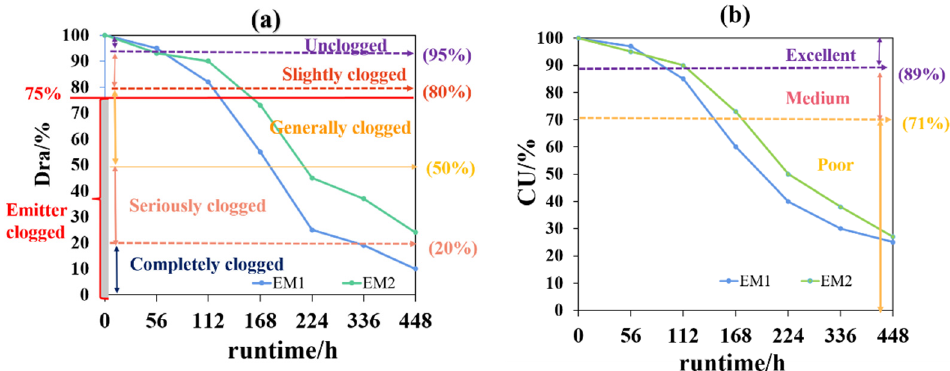
Figure 5. Performance evaluation method of emitters clogging. ( a ) The average discharge variation ratio (Dra). An emitter Dra is higher than 95% of the design is defined as unclogged, 80–95% is slightly clogged, 50–80% is generally clogged, 20–50% is seriously clogged, and less than 20% is completely clogged [14]. 75% is the standard for determining clogging that given by the International Organization for Standardization [32]. ( b )The christiansen of uniformity (CU). The performance of an emitter is defined as excellent if its CU is higher than 89%, 71–89% is medium, and 71% is poor [61]. EM1 and EM2 mean two types of flat emitters.